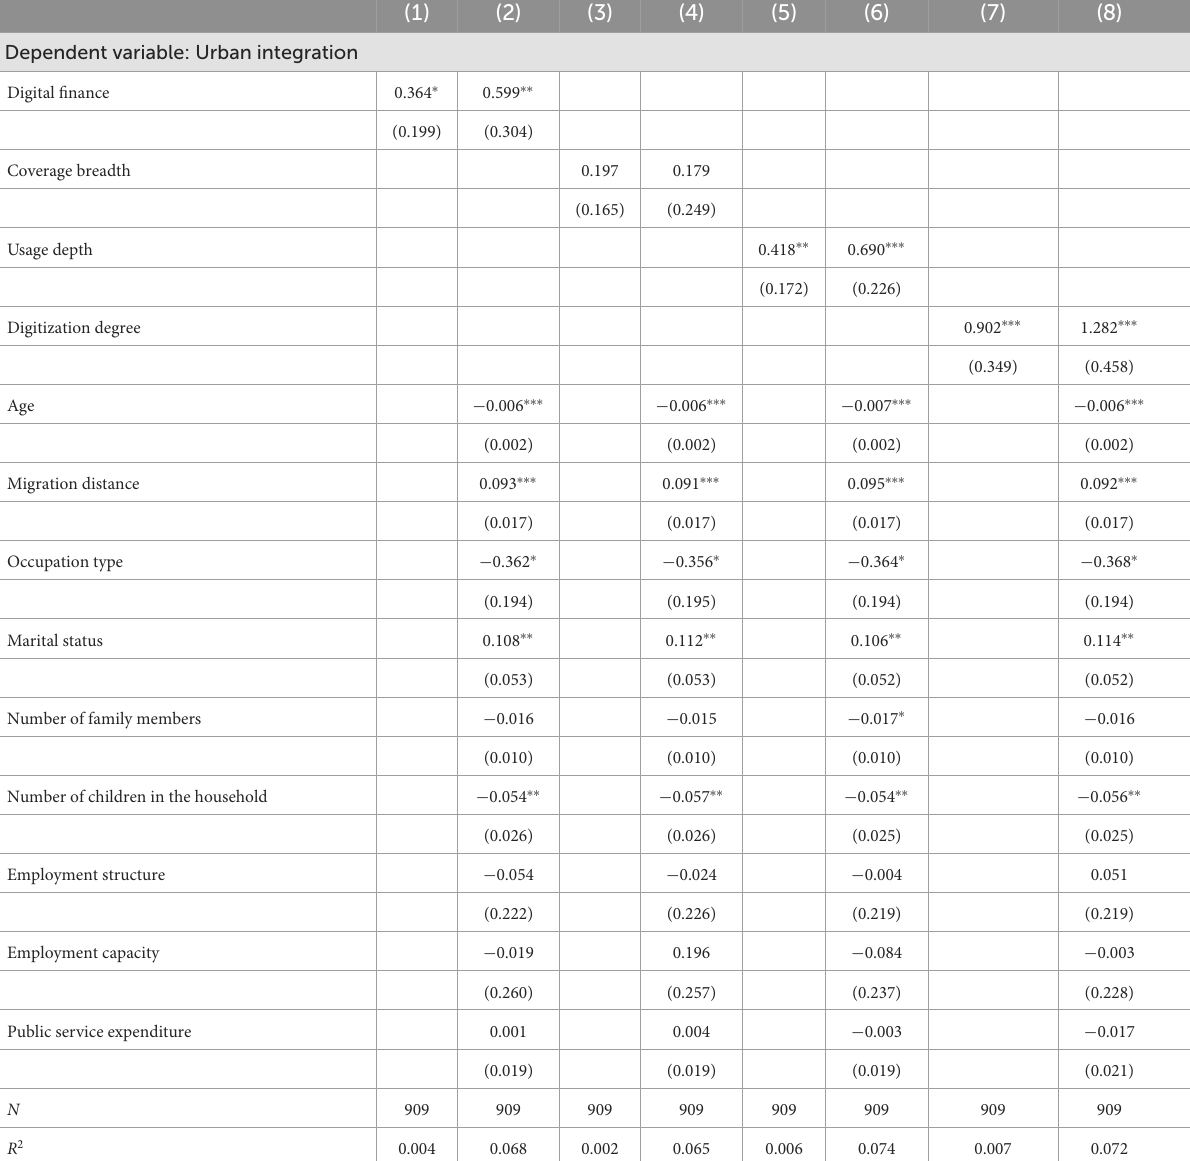
TABLE 3 Estimates of the impact of digital finance and its dimensions on migrant workers’ urban